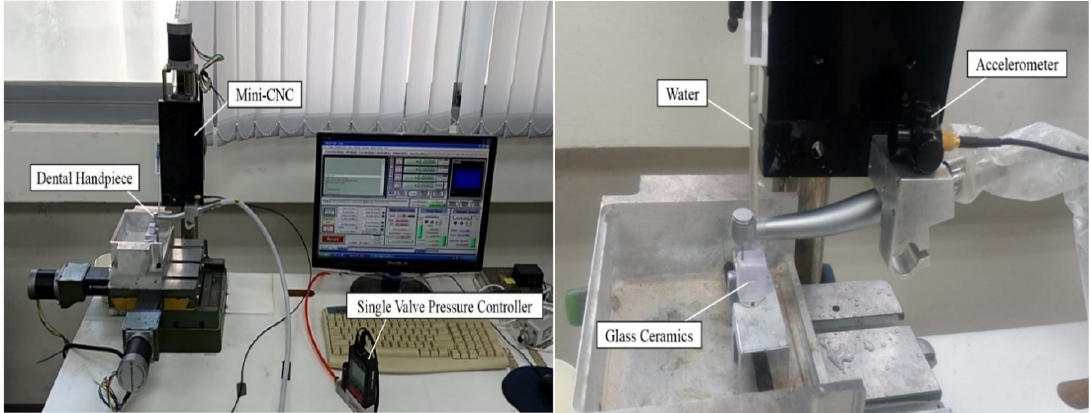
Figure 6. Triaxial CNC dental handpiece used in the cutting experiment.